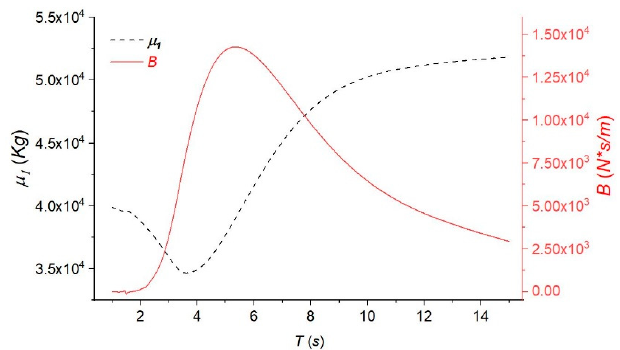
Figure 9. Plots of added mass 𝜇 (cid:2869) and radiation damping 𝐵 versus energy period 𝑇